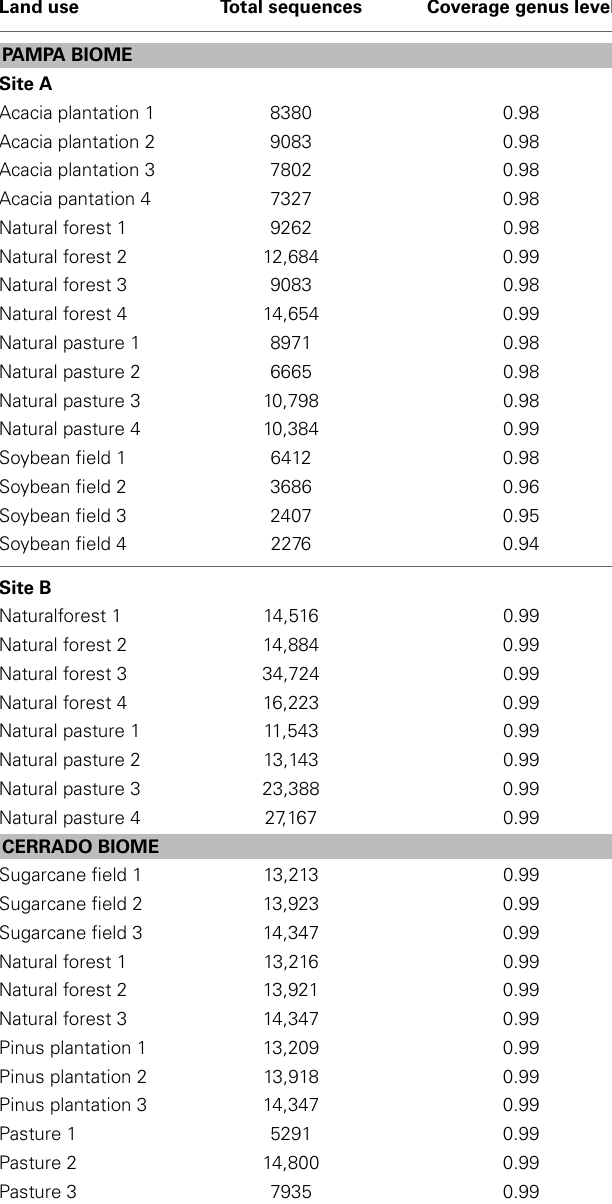
Table 1 | Total number of high-quality sequences and sequencing coverage for taxonomic genus level in land uses in Pampa